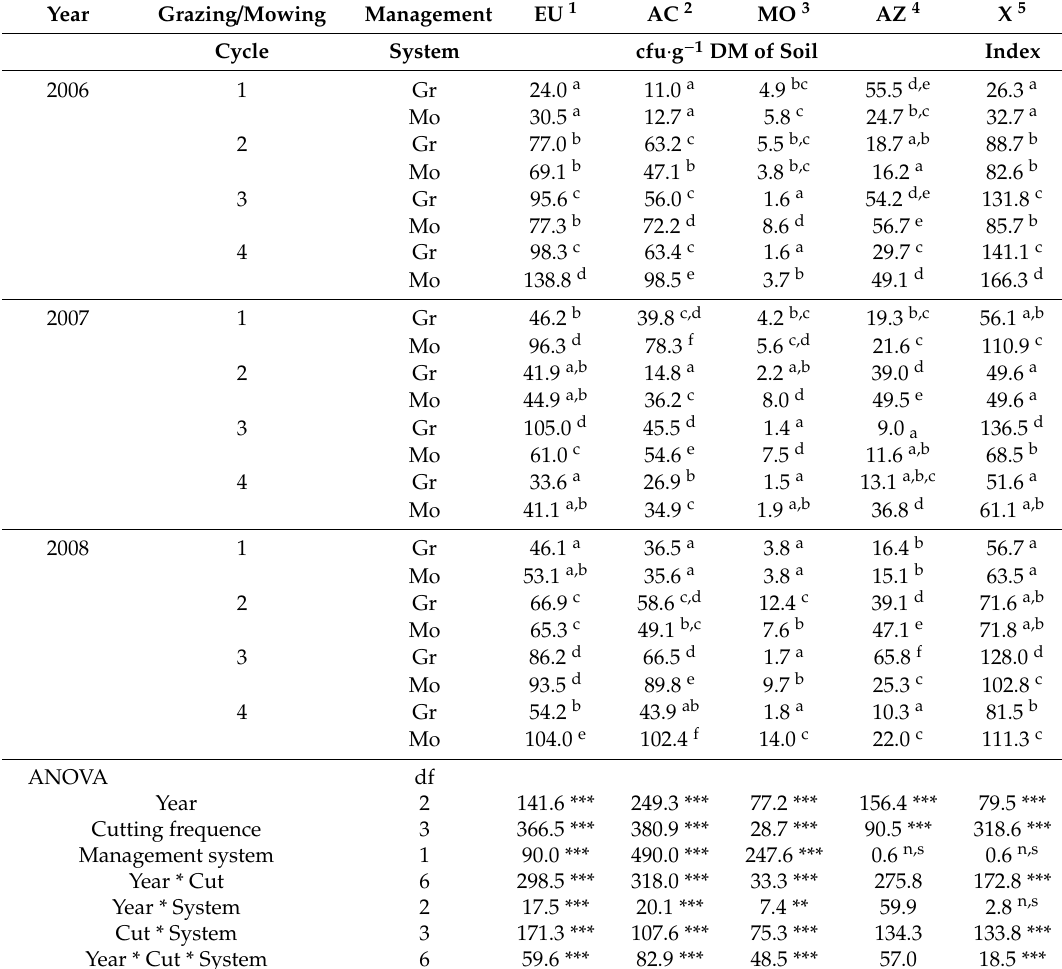
Table 2. Microbial population counts in pasture soil under two di ff erent management systems and subjected to grazing / mowing cycles, during a three-year